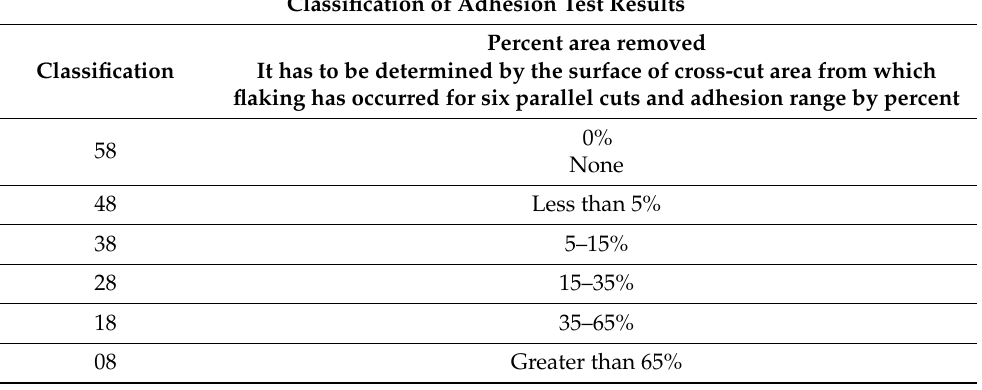
Table 4. Classification of the cross-cut test (on the basis of